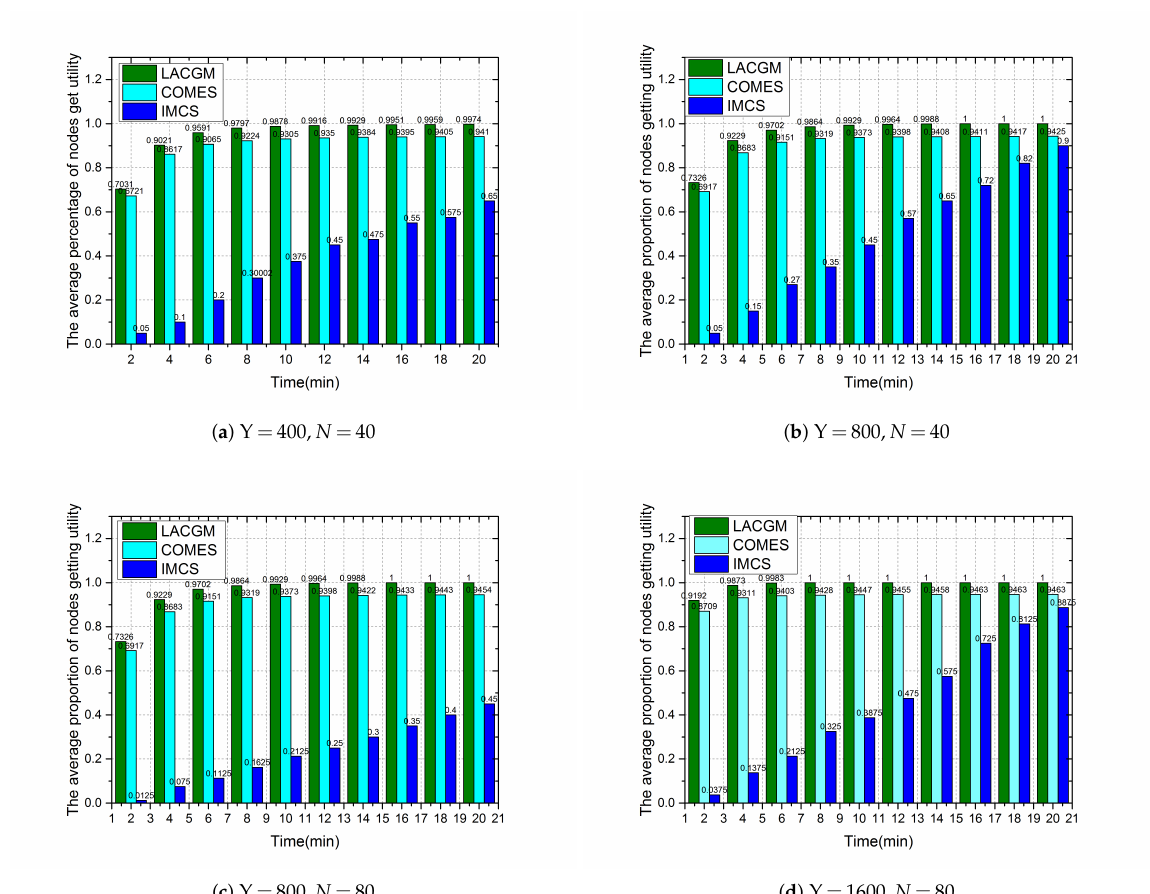
Figure 9. Proportion of nodes acquiring utility vs. the number of messages and